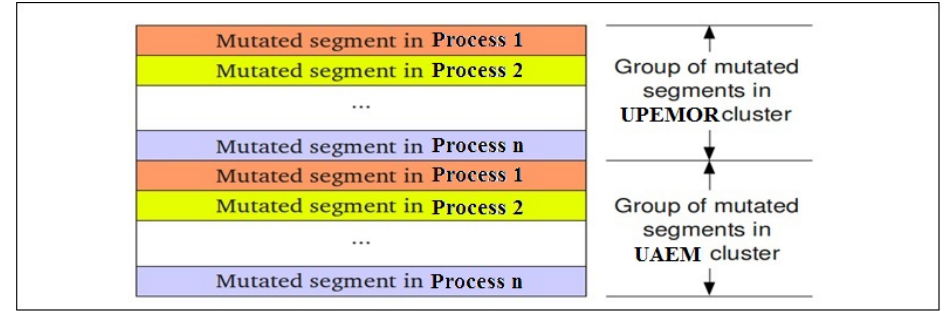
Figure 8. Population produced by the combination of mutated segments in the MiniGrid processes.